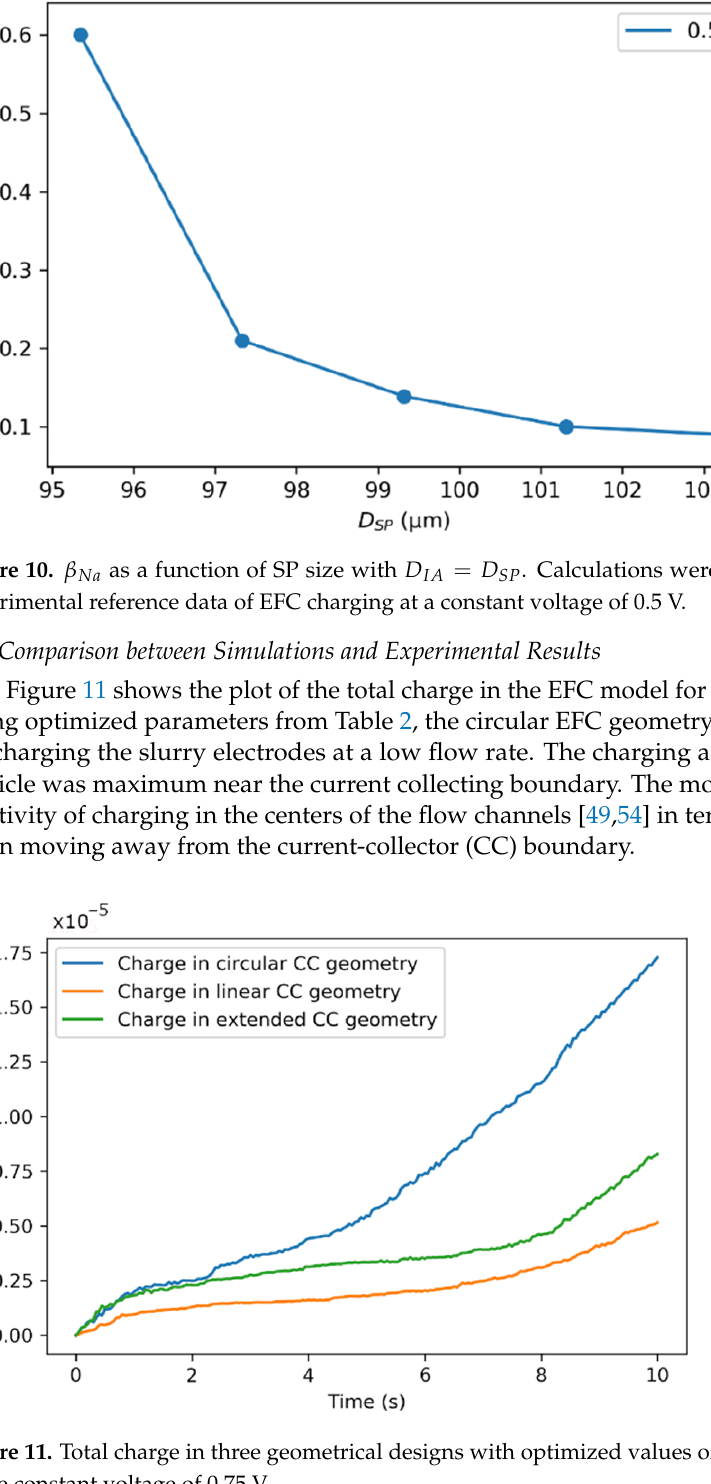
Figure 11. Total charge in three geometrical designs with optimized values of modeling parame- ters at the constant voltage of 0.75 V.